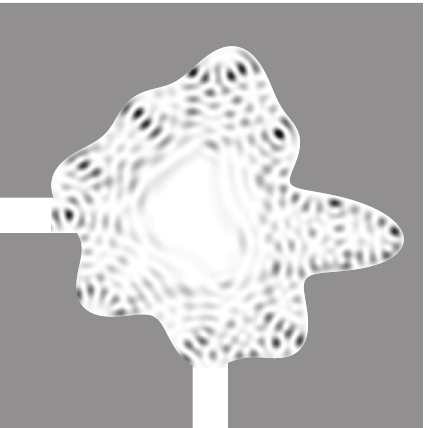
√ 32 π , (cid:4) B = 9, and the fundamental mode